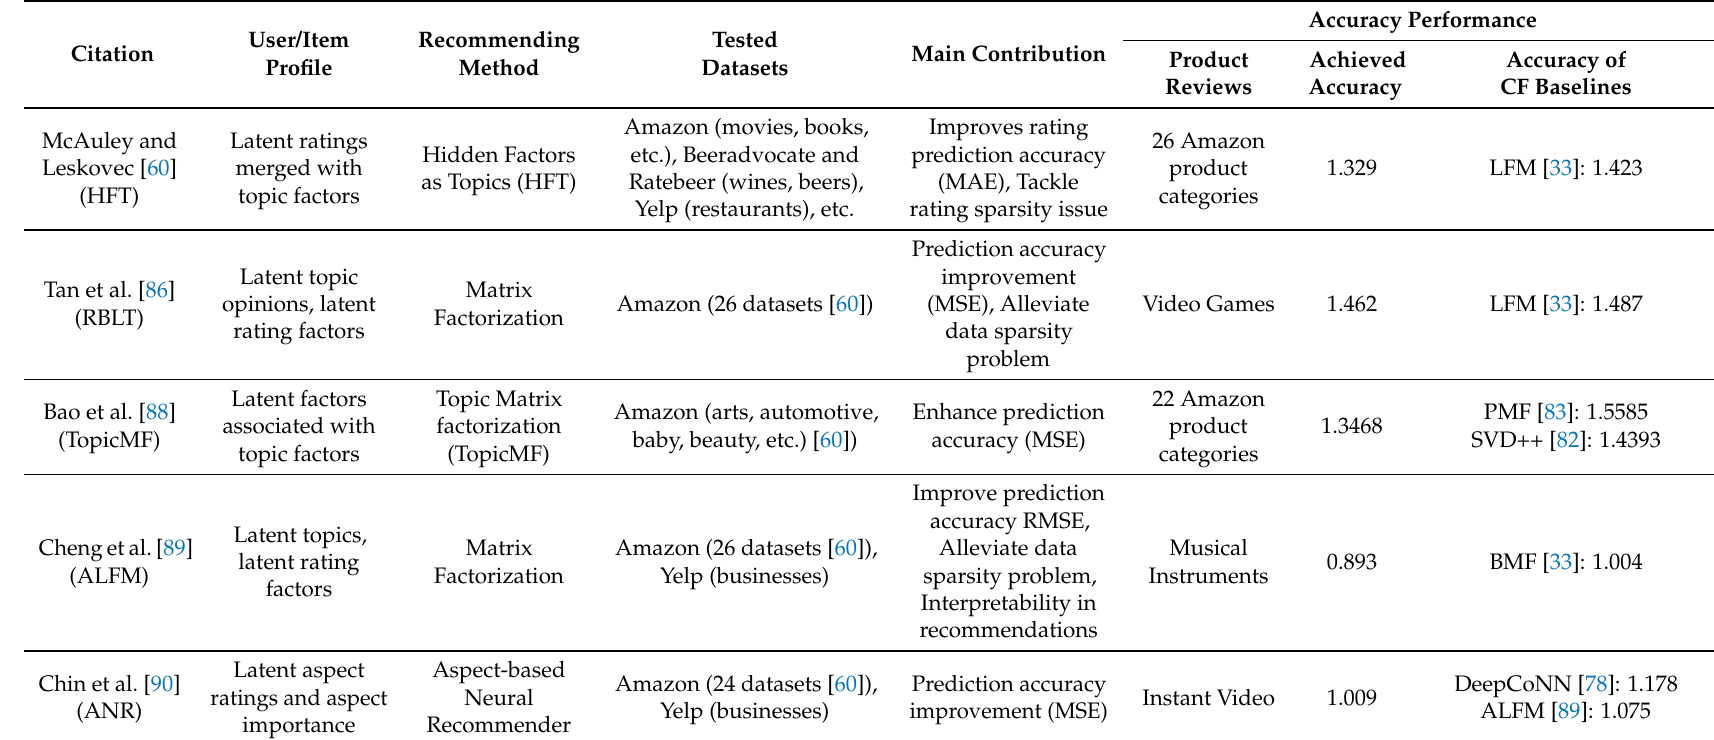
Table 4. Related works on techniques based on review